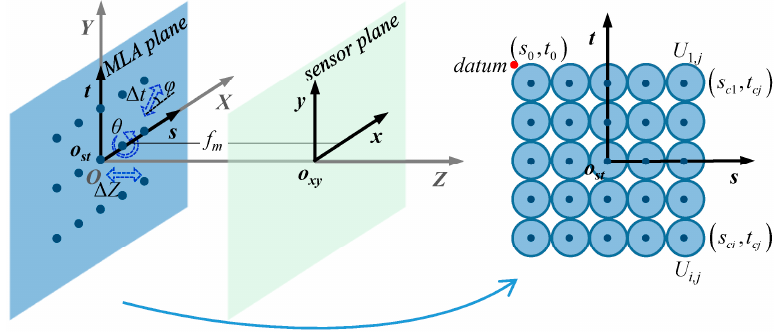
Figure 2. Illustration of the coordinate system in the MLA error model.